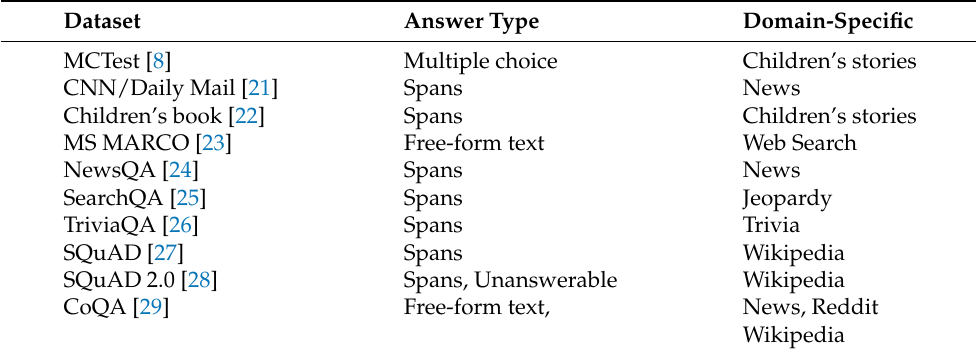
Table 1. List of some existing MRC